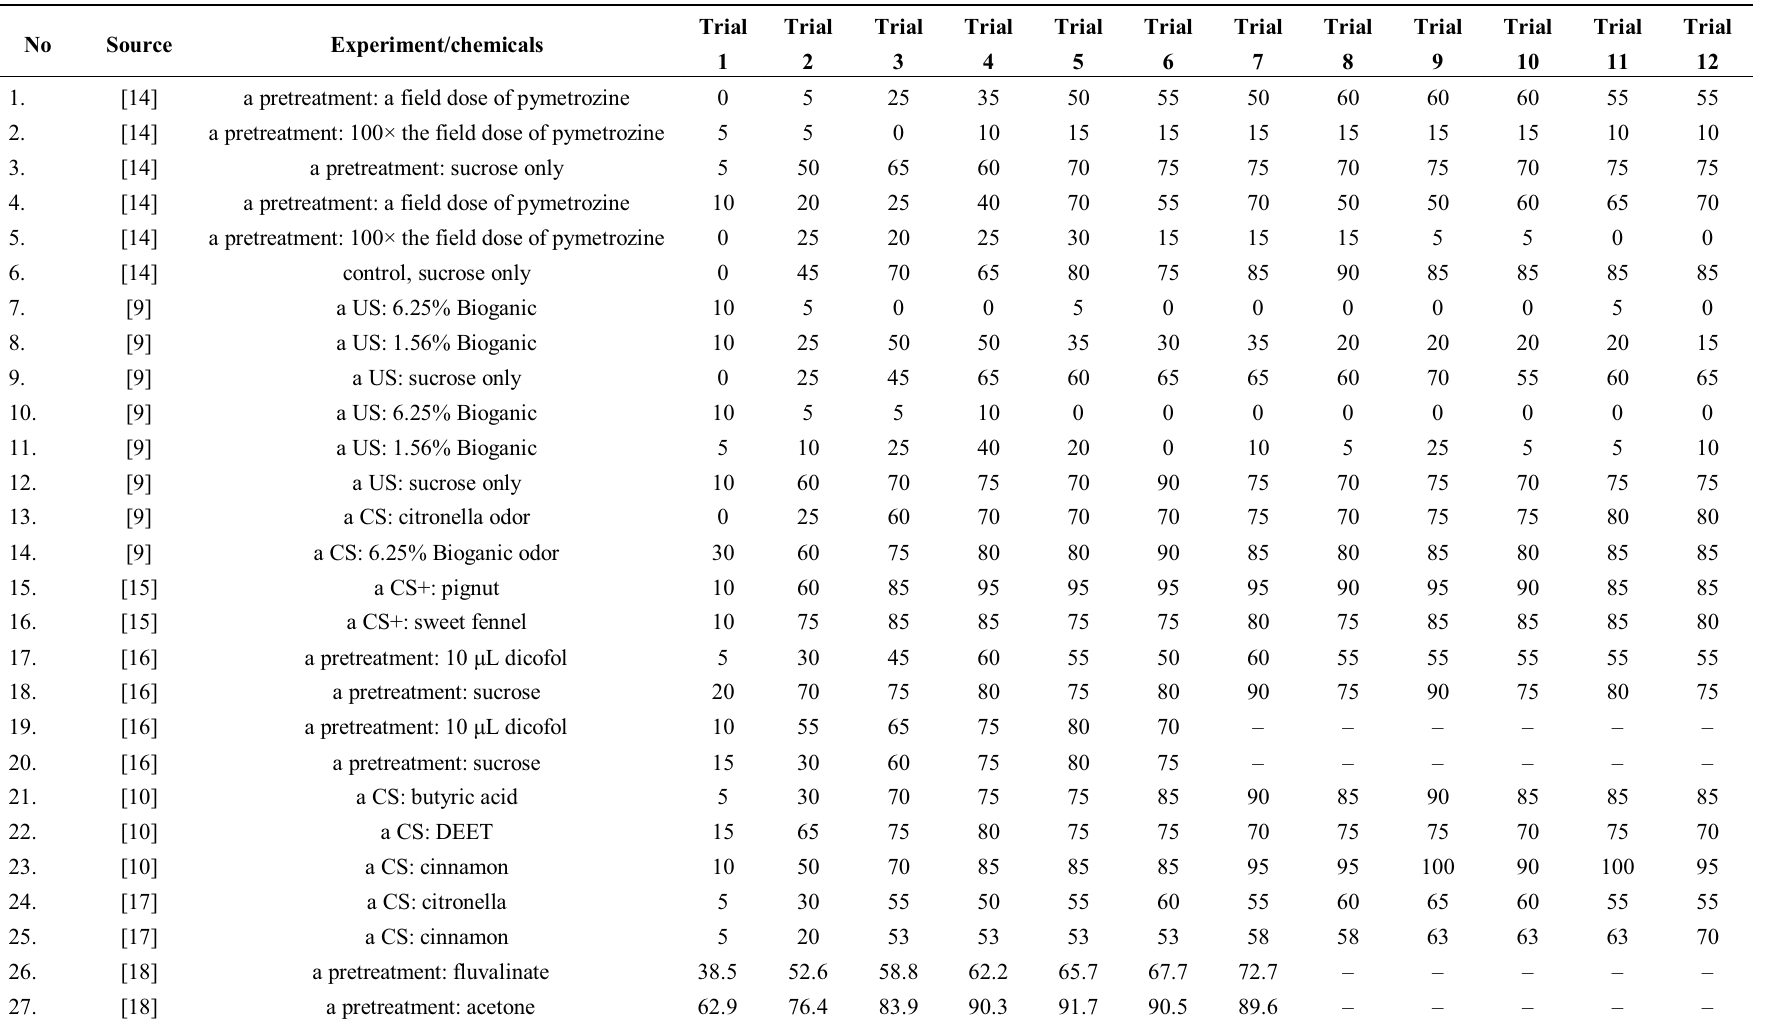
Table 1. Raw bee learning data. The raw data are presented to aid researchers who wish to apply other models of the learning process, as well as to provide context for the B2, B3 and B4 values. The source listed is the original source of the data, and can be found in the